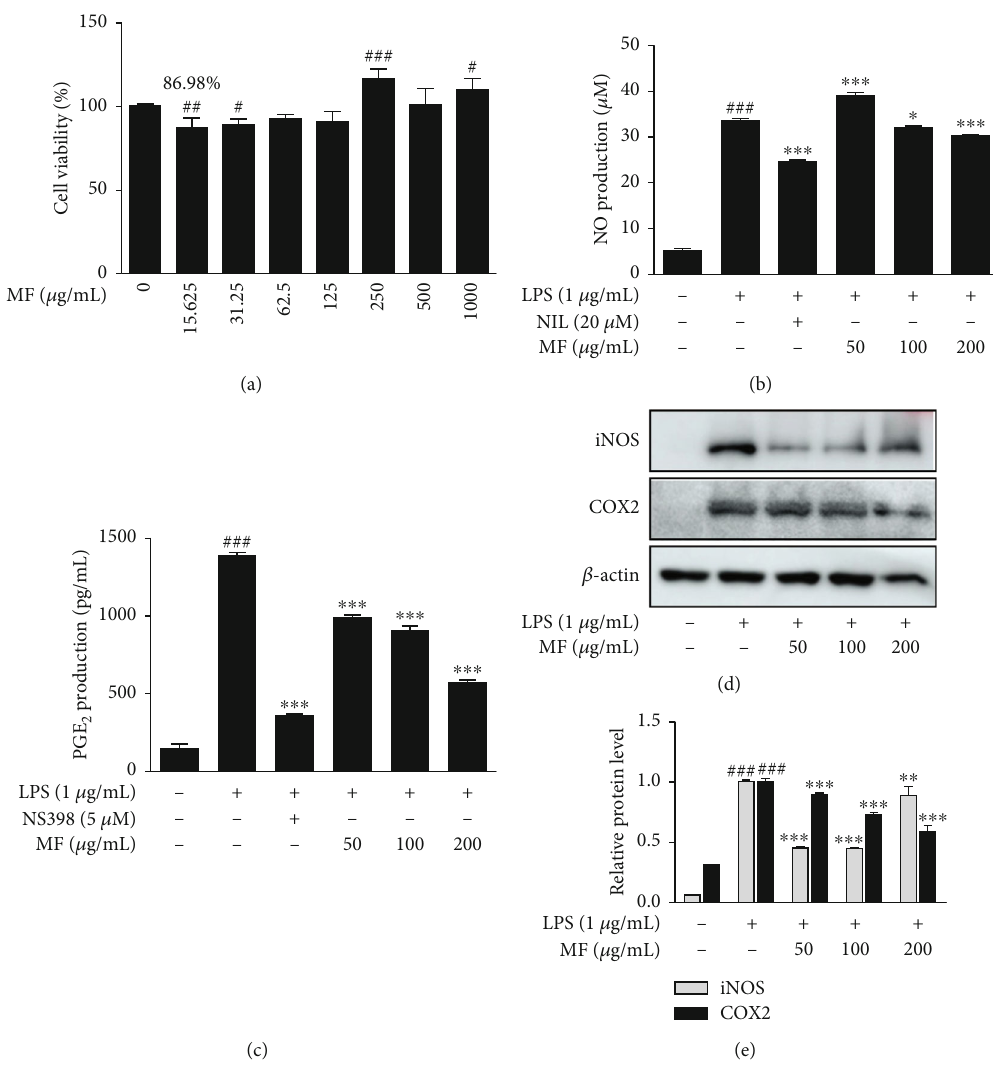
Figure 3: E ff ect of MF on proin fl ammatory mediators in LPS-stimulated RAW264.7 macrophages. (a) The cells were treated with various concentrations of MF for 24h, and their viability was determined by MTT assay. (b and c) The cells were treated with 50, 100, or 200 μ g/mL of MF for 1h prior to the addition of LPS (1 μ g/mL) and were incubated for 24h. NO and PGE and EIA kit, respectively. NIL (20 μ M) and NS398 (5 μ M) were used as positive controls for NO and PGE The protein levels of iNOS and COX2 were determined by western blot with speci fi c antibodies. Densitometric analysis was performed using ImageJ software. The data are presented as the mean ± SD . ## p < 0 : 01 and ### p < 0 : 001 vs. the control group; ∗ p < 0 : 05 , ∗∗ p < 0 : 01 , and ∗∗∗ p < 0 : 001 vs. the LPS-treated